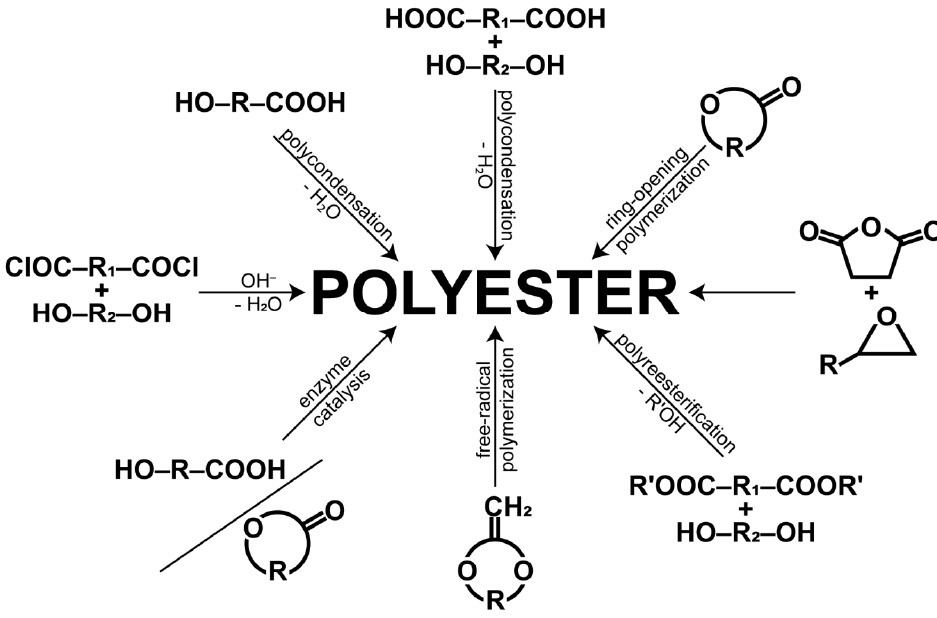
Figure 1. An overview of the synthetic routes used for the synthesis of polyesters.